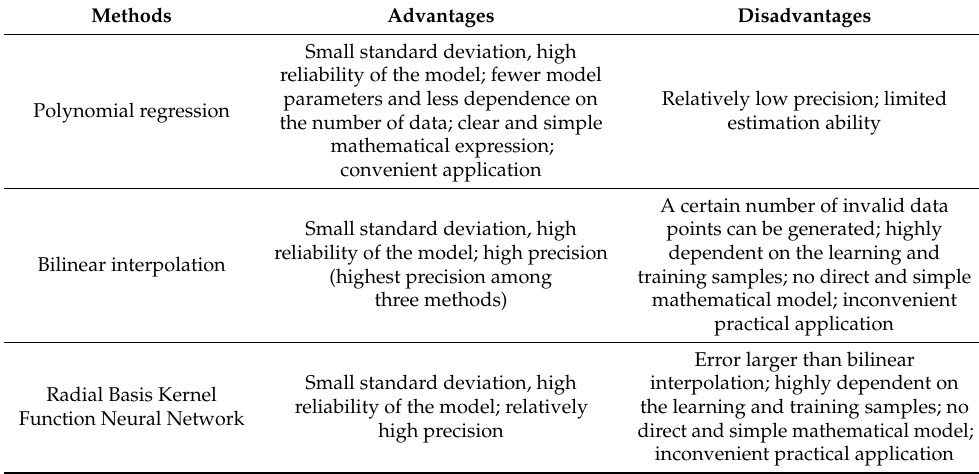
Table 6. Comparison of advantages and disadvantages of three modeling methods.